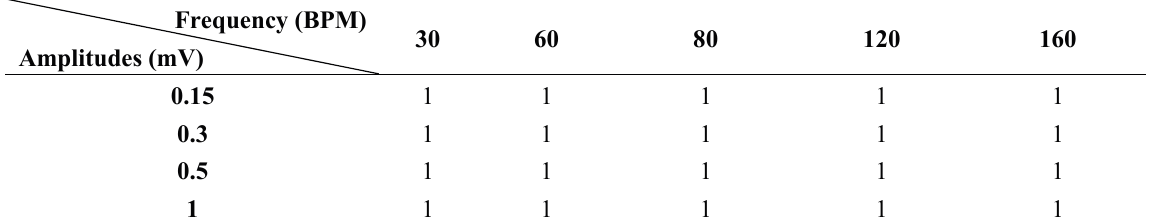
Table 5. Average QRS amplitude ratio between ECG generator device and the proposed sensor.